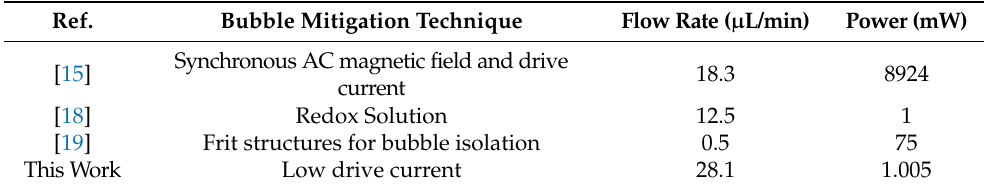
Table 1. Flow rate and power consumption of different MHD pumps with bubble mitigation. Ref.